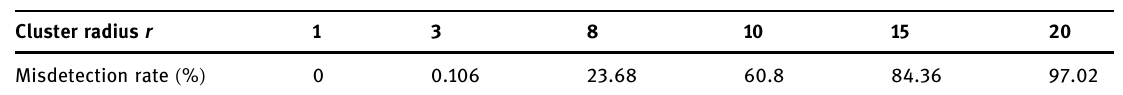
Table 6: False detection rate